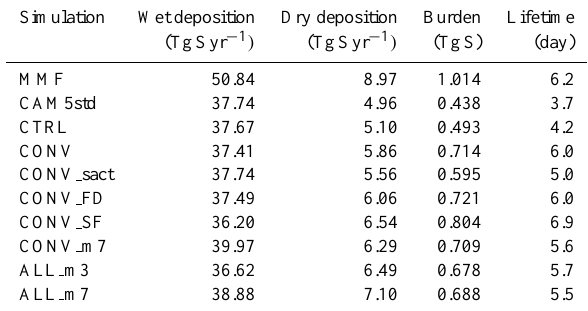
Table 3. Global annual (non-sea-salt) sulphate aerosol budgets in MMF and CAM5